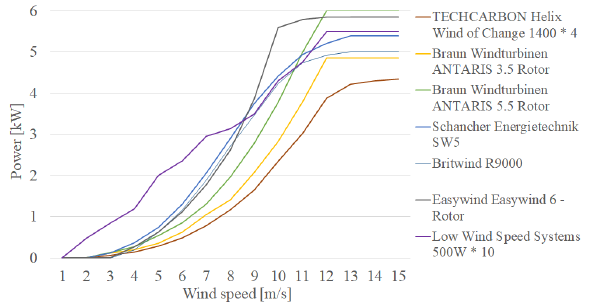
Figure 9. Comparison of small wind turbine power curves.